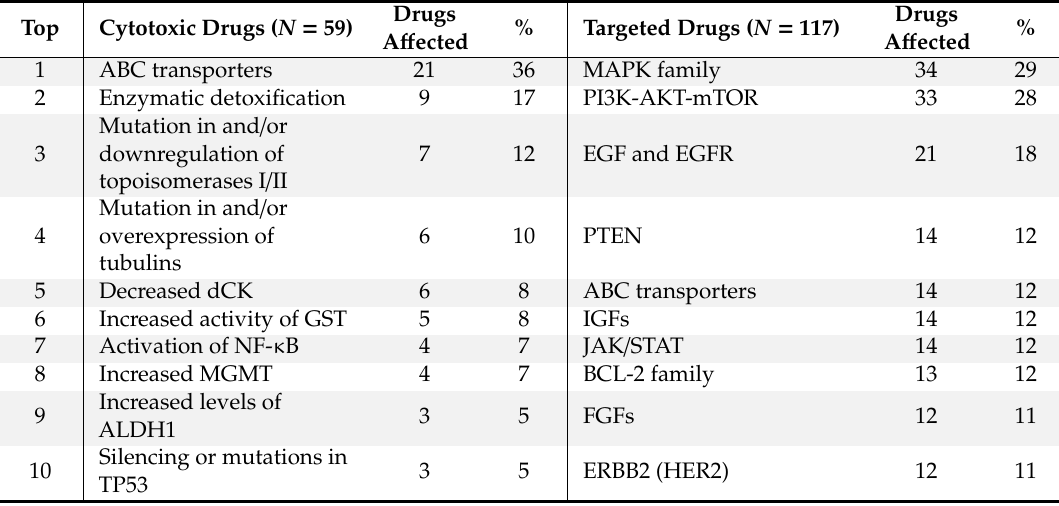
Table 1. Most common specific resistance mechanisms and signaling pathways associated with cytotoxic and targeted